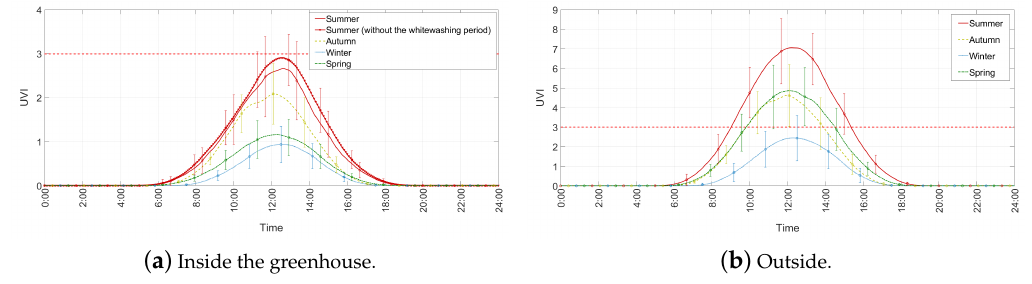
Figure 11. Average day and standard deviation ( ± 1 σ ) of UVI per